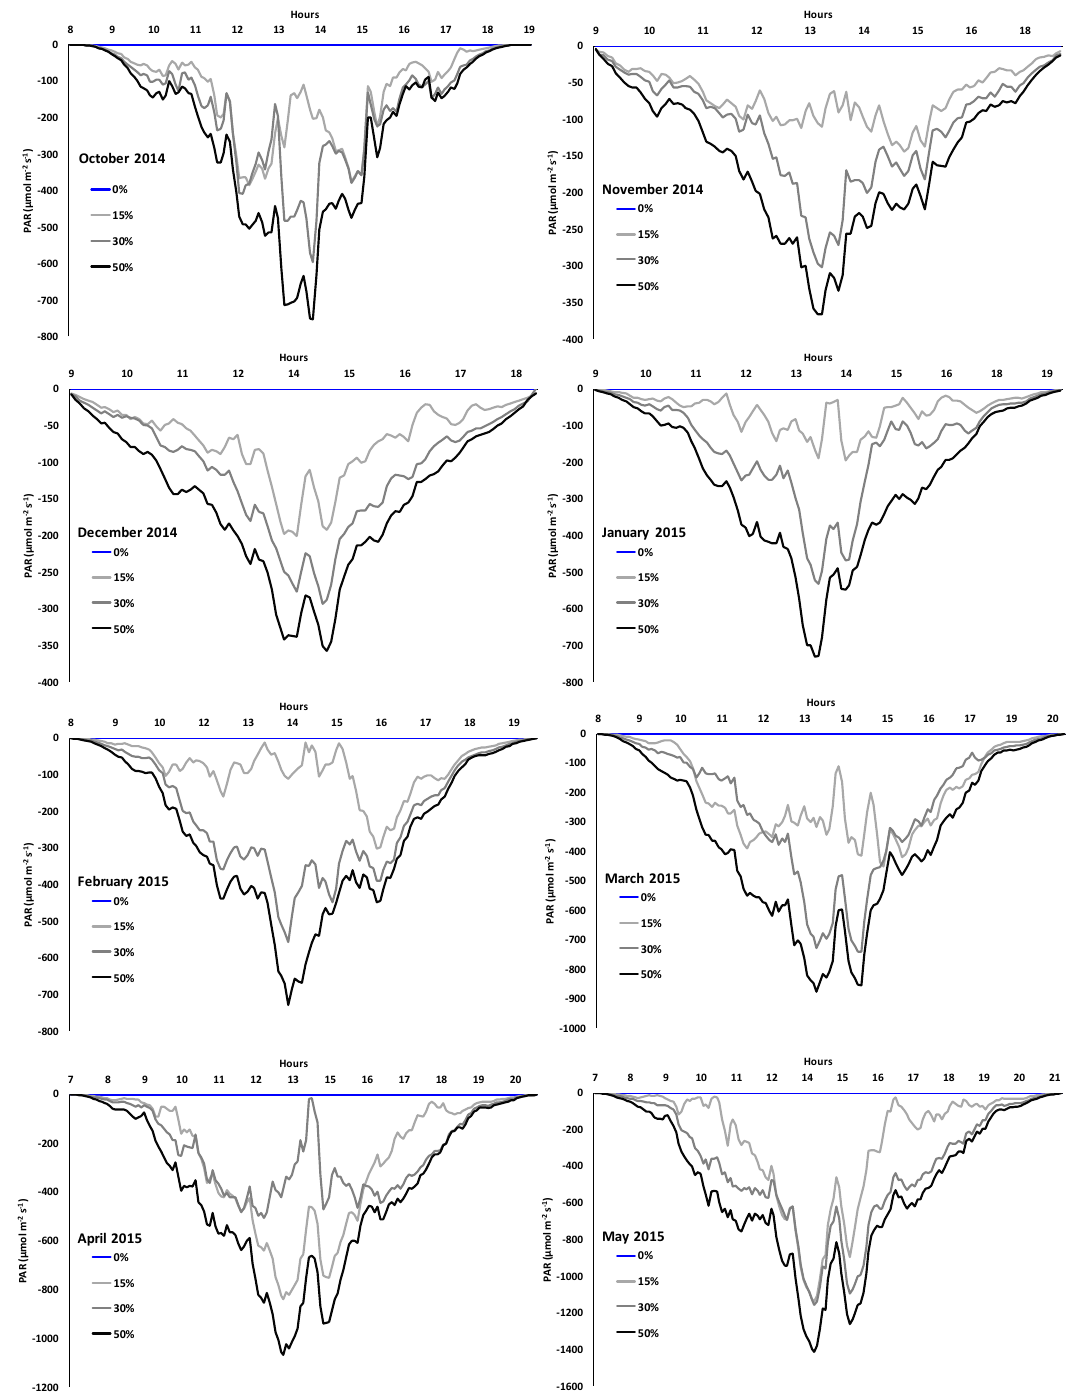
Figure 8. Average daily evolution of the monthly reduction of PAR radiation produced by shading treatments (15%, 30% and 50%) in regards to the control treatment (0%) shade for the studied period.